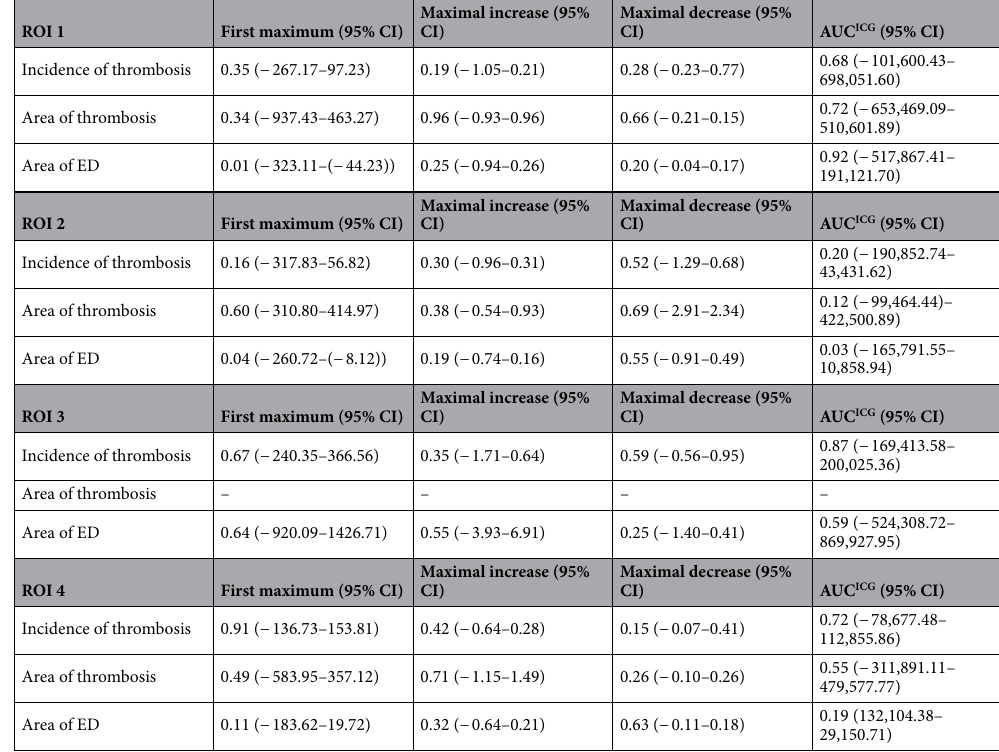
Table 5. Univariate regression analysis of incidence of thrombosis, visual area of thrombosis, and visual area of endothelial defect of the analyzed ICGVA parameters. 95% CI 95% Confidence interval, ROI Region of interest, AUC ICG Area under the